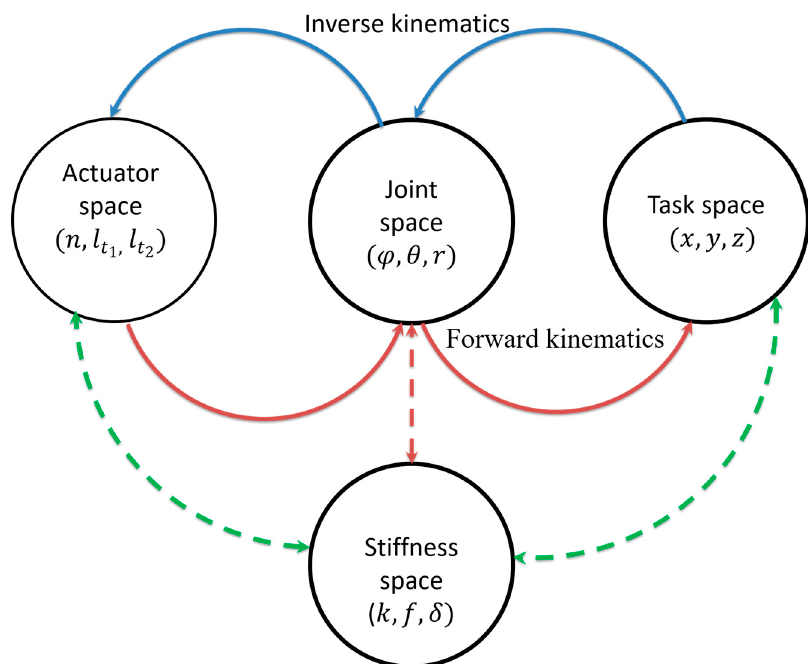
Figure 6. Mapping between stiffness, actuator, joint, and task space. n = number of rotations of the motor; l t 1 , l t 2 = lengths of the tendons; ϕ = rotation of the module about the z -axis; θ = bending angle of the module; r = radius of curvature; ( x , y , z ) = end-effector coordinate points; k = stiffness of the beam; f = bending force; δ = deflection of the